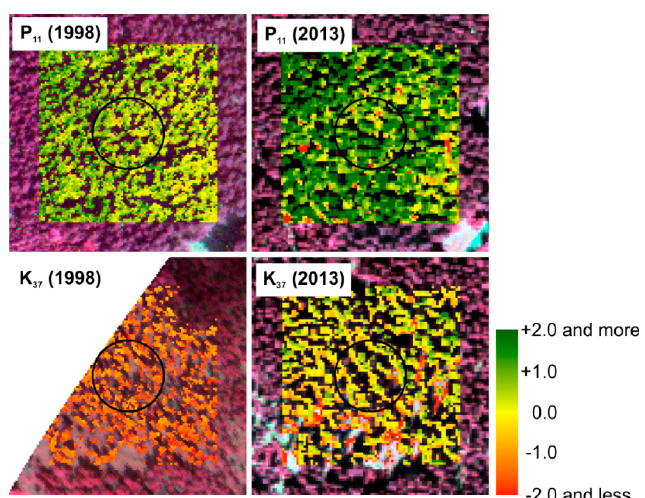
Figure 6. Normalized values of the VOG 1 vegetation index calculated from the ASAS (1998) and APEX (2013) hyperspectral imagery datasets in the original 2 m spatial resolution for P 11 (western Ore Mountains—less damaged) and K 37 (central Ore Mountains—more damaged) stands. The lower values (shown in red colour) correspond to relatively worse physiological status, while high values (shown in green) correspond to a relatively good physiological status.